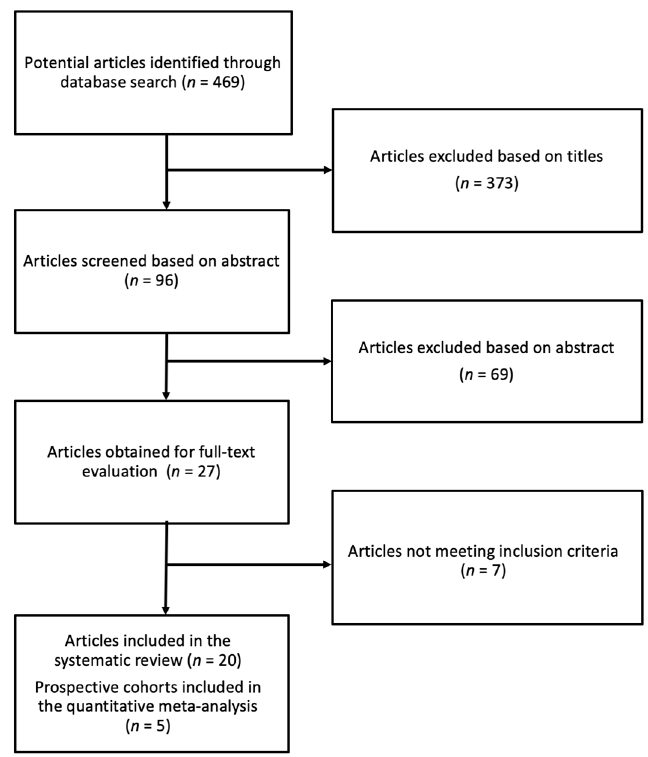
Figure 1. Process selection of relevant studies reporting on the association between dietary flavonoid intake and risk of hypertension.